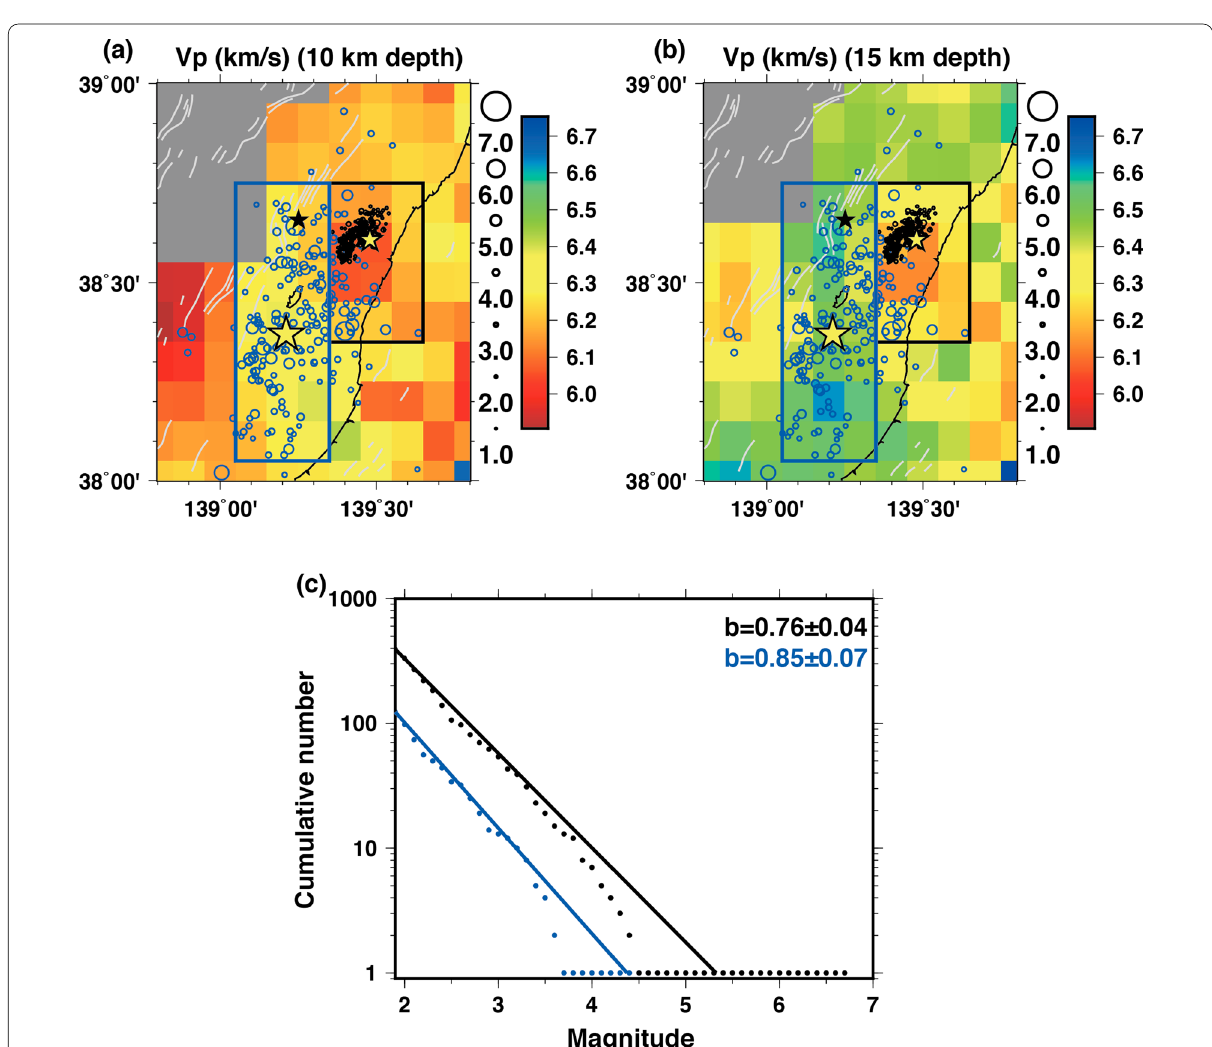
Fig. 4 Seismic-wave velocity structure and frequency–magnitude distribution. a Horizontal map of the P-wave velocity structure at 10 km depth, which was imaged by Matsubara et al. (2020). Black and yellow stars, blue circles, and gray lines are the same as in Fig. 1b. The black circles are the same as the red circles in Fig. 1b. b Horizontal map of the P-wave velocity structure at 15 km depth (Matsubara et al. 2020). See a for other details. c Cumulative frequency–magnitude distributions of the earthquakes that were recorded from 1998 and which occurred in the corresponding colored rectangular regions in a . The b -value is calculated using the formula of binned magnitude (Tinti and Mulargia 1987; Marzocchi and Sandri 2003). We define M 1.9 as the cutoff magnitude considering the goodness of fit (Wiemer and Wyss 2000) and the temporary deficiency of aftershocks immediately after the 2019 Yamagata-Oki earthquake (Additional file 1: Fig. S1b). The uncertainty is the standard deviation estimated using the bootstrapping